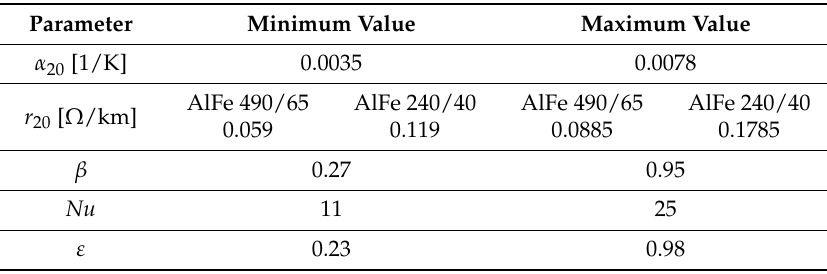
Table 5. Minimum and maximum values of optimization variables.